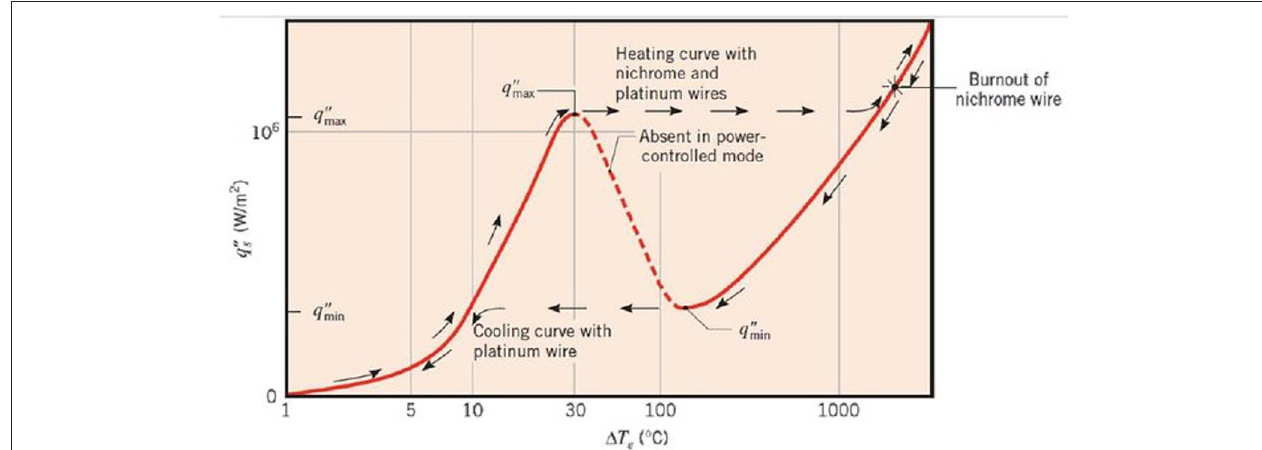
FIGURE 4 | Typical boiling curve (Nukiyama,